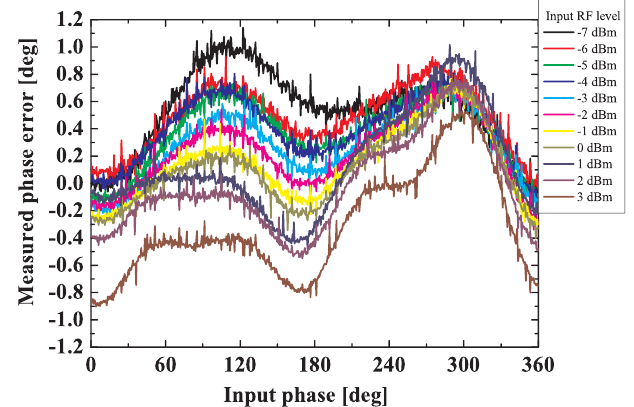
FIG. 5. (Color) Photograph of the fast phase detector (I/Q de- tector). Its dimensions are 480 mm (cid:4) 230 mm (cid:4) 50 mm ( W (cid:4) D (cid:4) H ).